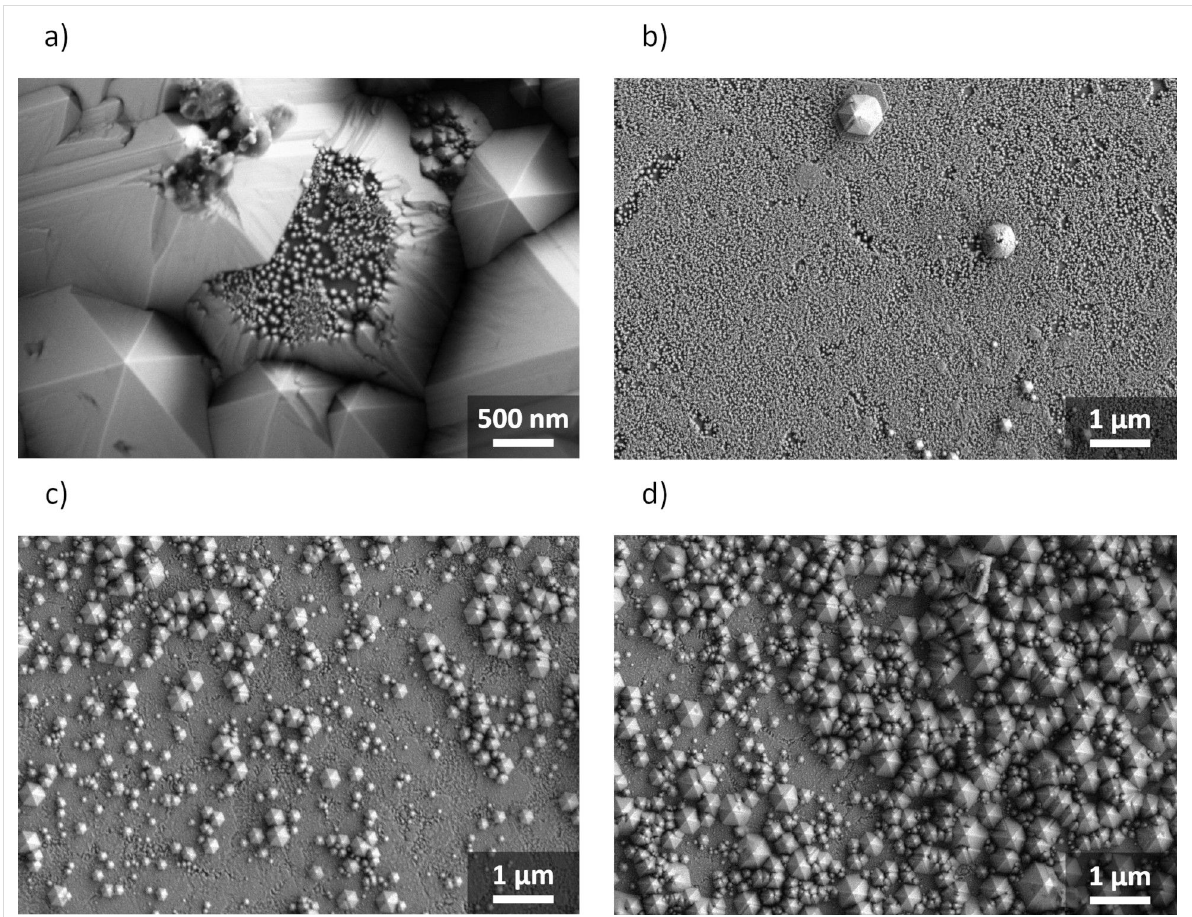
Figure 8: SEM image of the second 2D–3D transition plateau on pyramid top of E after etching in 30 wt % KOH solution at 80 °C for 50 min (a). SEM images of different sections of identical sample E , after etching in 30 wt % KOH solution at 70 °C for 3 min and subsequently 5 h at RT (b–d).